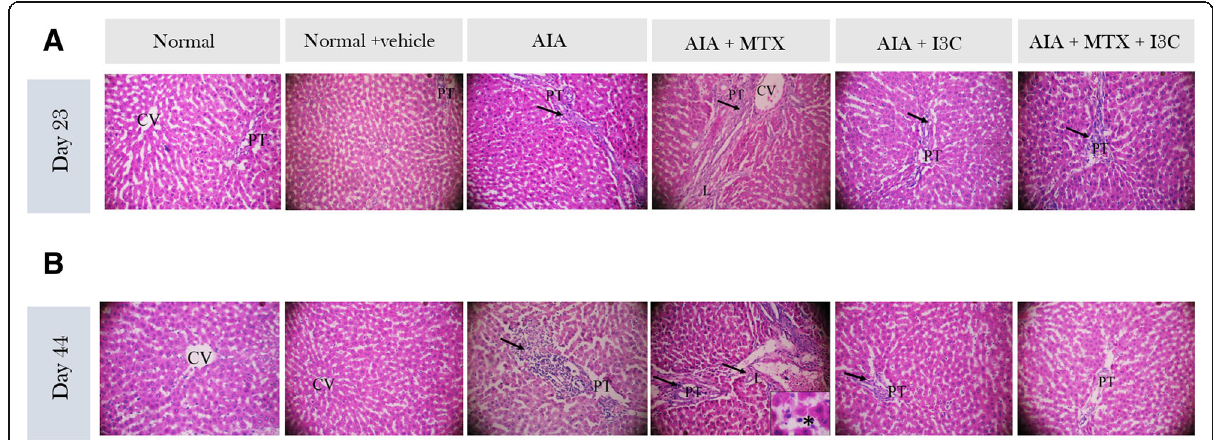
Fig. 6 Studying effect of I3C on liver at a histological level on day 23 ( a ) and day 44 ( b ). H & E staining was employed to grade portal and lobular inflammation ( → ) and necrosis (*). Liver section of both normal groups show normal central vein (CV) and surrounding hepatocytes. Arthritic-non treated model group show inflammation in the portal tract. Treatment with methotrexate resulted in infiltration of cells in portal and lobular tract with mild congestion and necrosis (*) at day 44 (× 400). Treatment with I3C improved the architecture showing only mild portal inflammation. Liver section of arthritic group concurrently treated with MTX and I3C show portal inflammation with diffuse inflammatory cells (arrow). PT: portal tract, L: lobular, CV: central vein. Magnification is × 100 unless mentioned